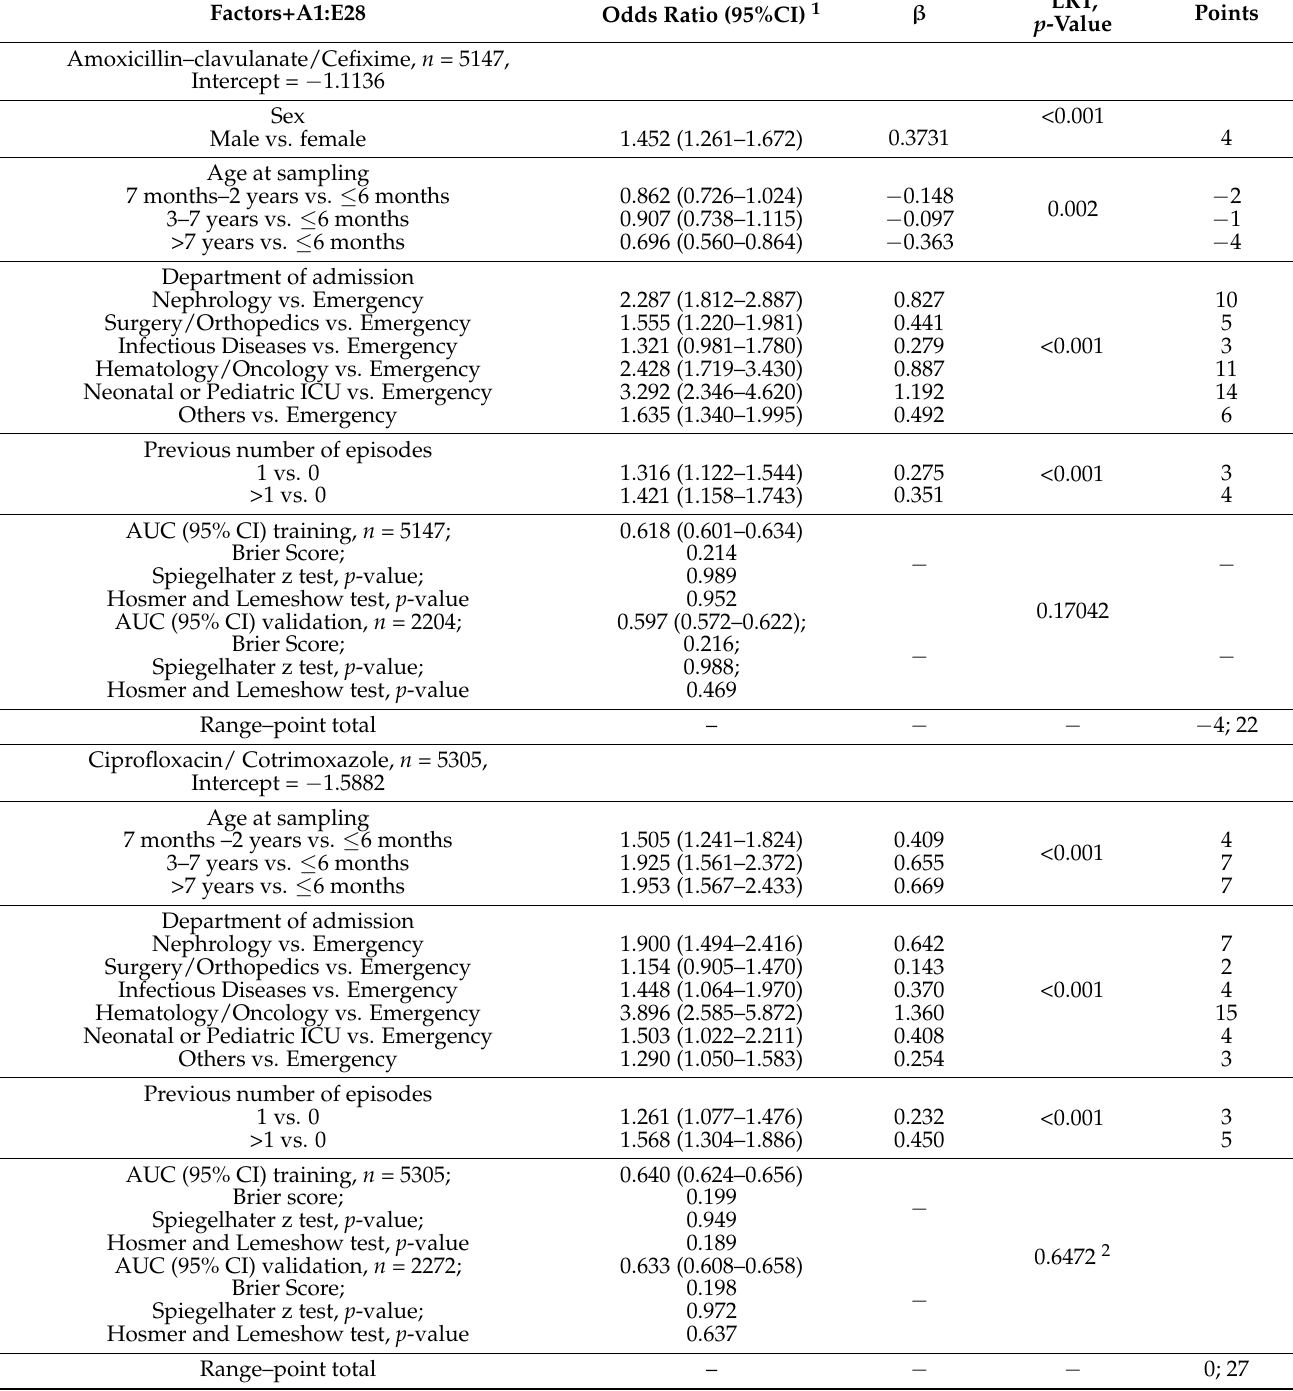
Table 3. Multivariable logistic regression models of training data sets. Models and points system to predict risk of specific drug-resistant urinary tract infection due to Enterobacteriales